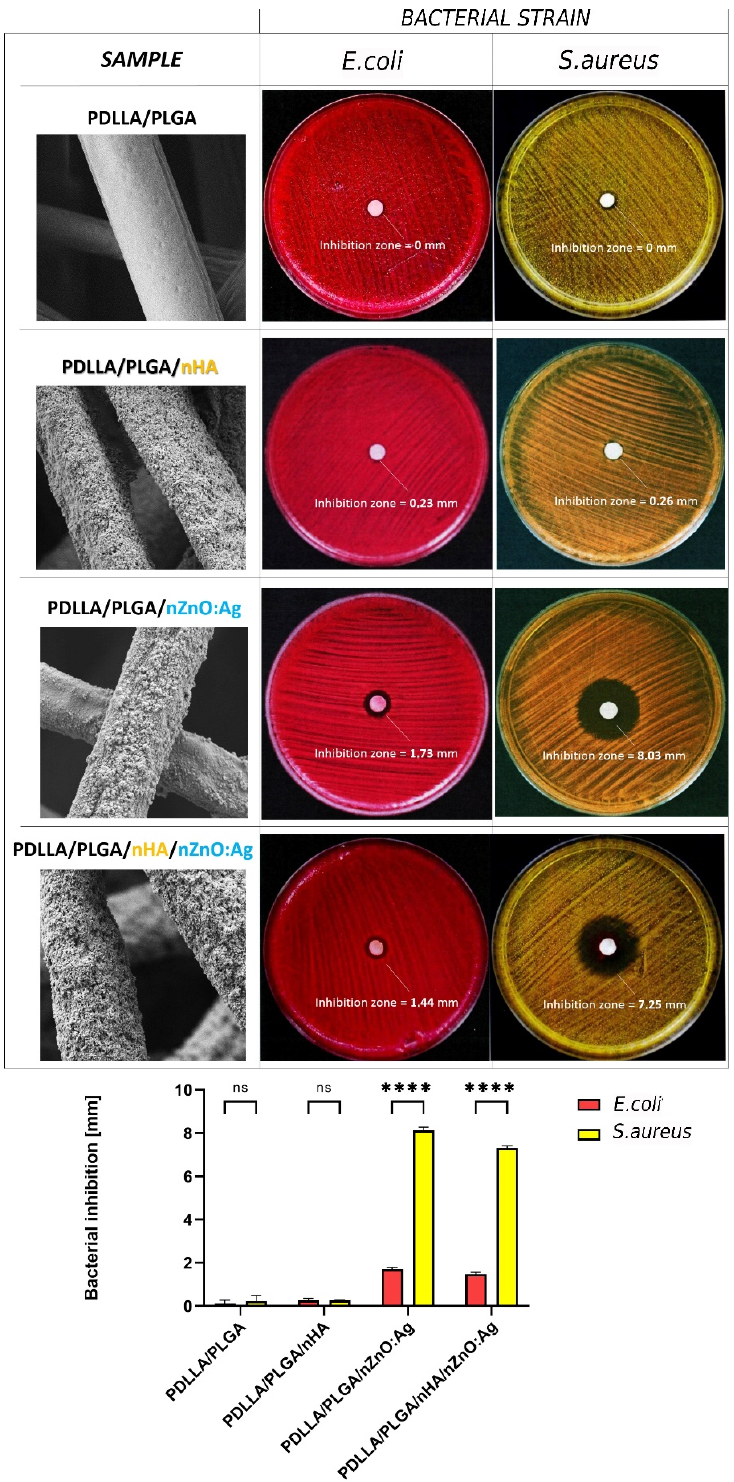
Figure 8. Representative SEM images and photographs of the bacterial inhibition zones formed by the different samples in contact with Escherichia coli and Staphylococcus aureus bacterial strains. The data are represented as mean ± SD ( n =3). Differences between tested samples were considered as statistically significant if **** p < 0.05, while nonsignificant results are marked as ns (one-way ANOVA, followed by Šídák’s multiple comparisons test).